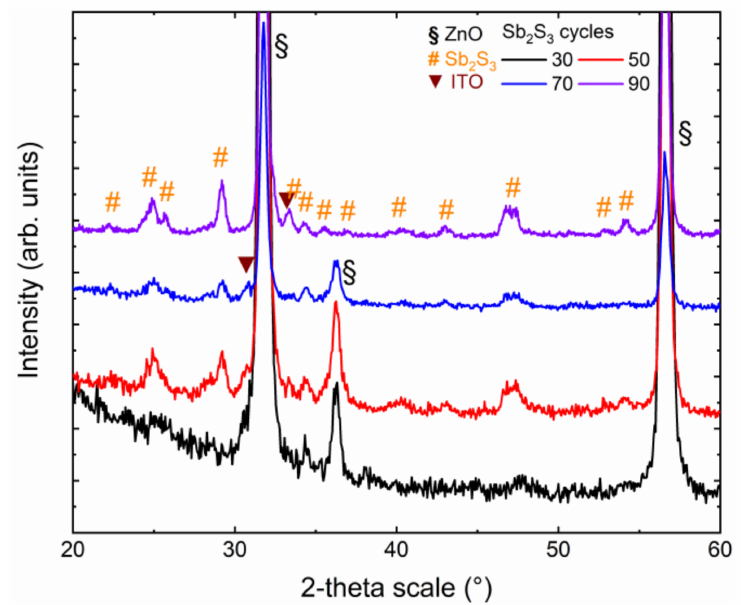
Figure 2. In-plane XRD patterns of ZnO/TiO 2 core–shell NW heterostructures covered with a Sb 2 S 3 shell grown by CSP, using 30, 50, 70, and 90